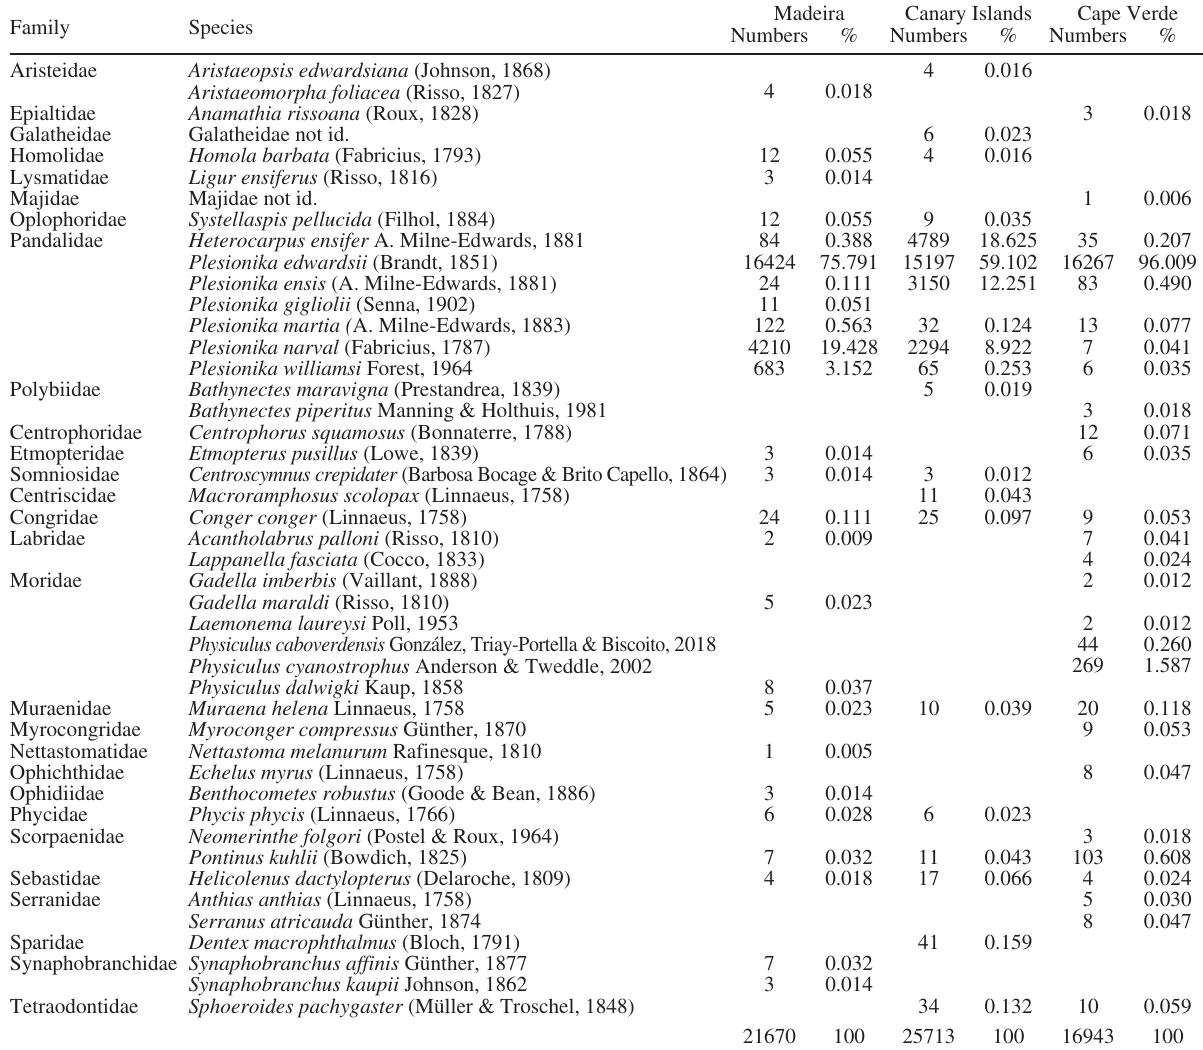
Table 1. – Species composition of macrofauna in numbers and in percentage of the semi-floating shrimp-trap fishery in Madeira, the Canary